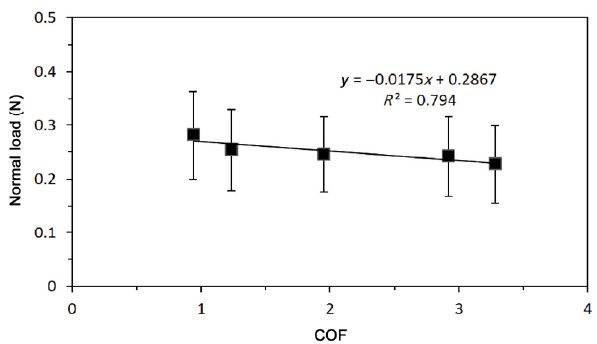
Fig. 7 The average normal load versus COF.